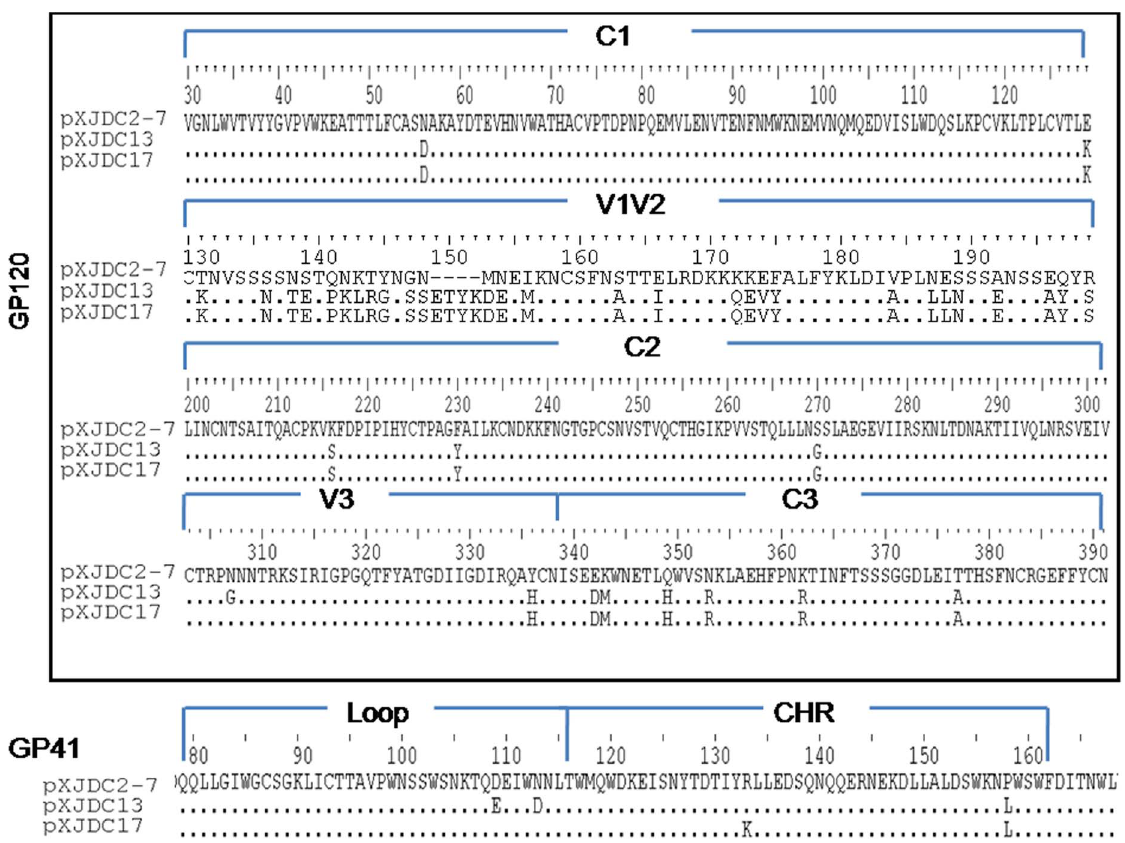
Figure 5. Differences in amino acid sequence in the env gene between the two infectious clones (pXJDC13, pXJDC17) and replication-defective clone pXJDC2-7. Substitutions or deletions within each region are shown; conserved amino acids are indicated with the character ‘‘.’’ and deletions are indicated with the character ‘‘ 2 ’’.